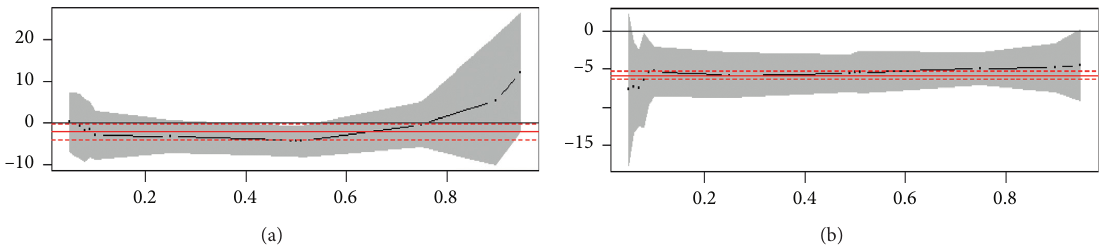
Figure 2: Estimation formula (15) of regression coefficients at different loci (2). An empirical analysis of Hypothesis 2. (a) 􏽢 α loci. (b) 􏽢 α under different loci. 4